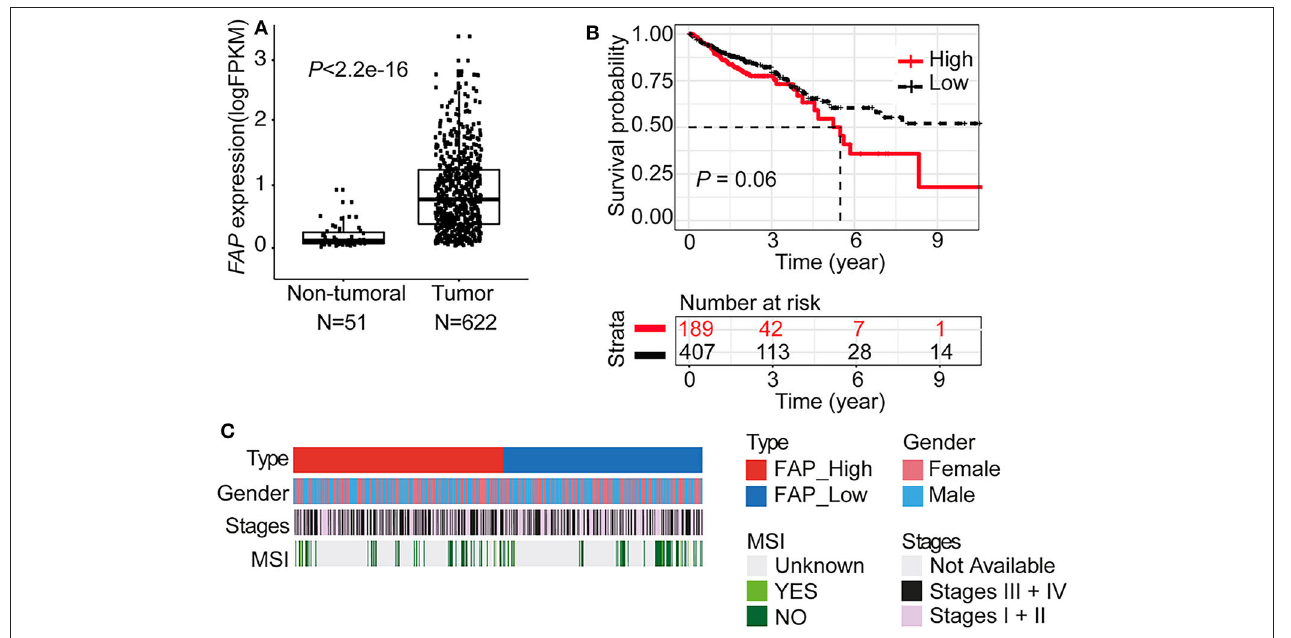
FIGURE 2 | FAP is upregulated in colorectal tumors. (A) FAP expression level in tumors ( n = 622) compared to non-tumoral tissue ( n = 51) in the TCGA data set. (B) Overall survival analysis (Kaplan–Meier) of CRC patients from the TCGA data set stratified by FAP expression (see also Supplementary Figure 2 ). (C) Colorectal cancer patient characteristics grouped by FAP expression. Statistical comparisons of clinical and molecular parameters between tumors with high vs. low FAP expression are shown in Table 2 . Statistical comparisons were performed Mann–Whitney U -test in (A) and by log-rank test in (B)